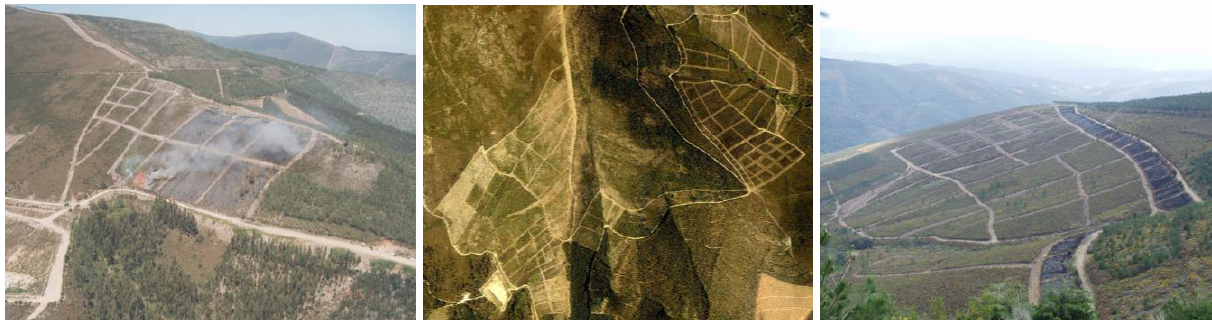
Figure 12. Pictures of the Gestosa experimental